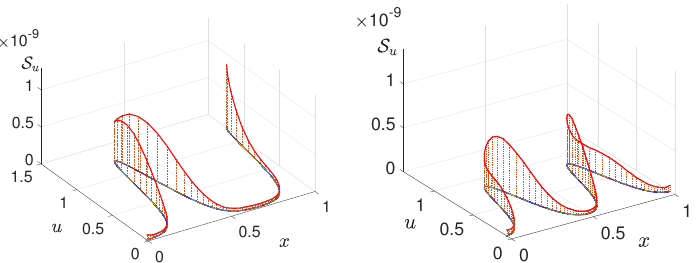
Figure 8. Mean-square deviation of random states around a 1.5 ↑ pattern ( left ) and 2 ↑ pattern ( right ) for Systems (1), (2) with a = d = e = 0.5, b = c = 1, D u = 5 × 10 − 4 , D v = 0.02, and ε = 10 − 5